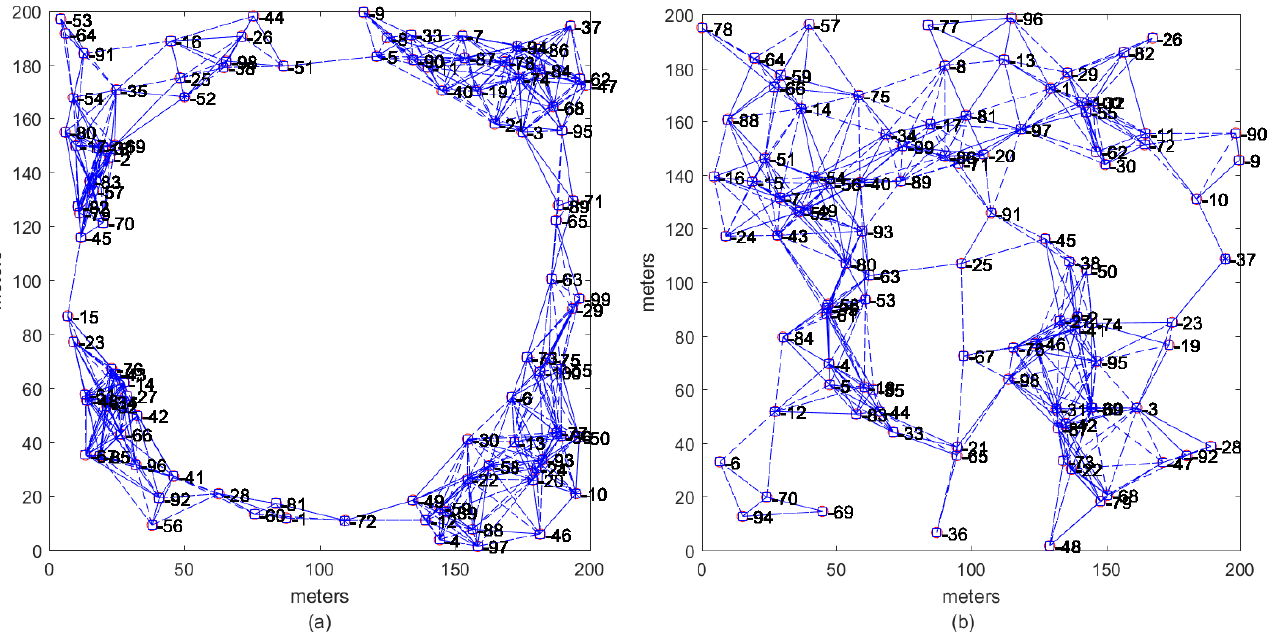
Figure 1. Multi-hop WSN topologies, where each connected network contains 95 unlocalized sensors and five anchor nodes. ( a ) Anisotropic circular connected network with sensor and anchor nodes randomly distributed in a circular shape. ( b ) Isotropic uniform distributed network with sensor and anchor nodes randomly distributed over a square area of 40,000 m 2